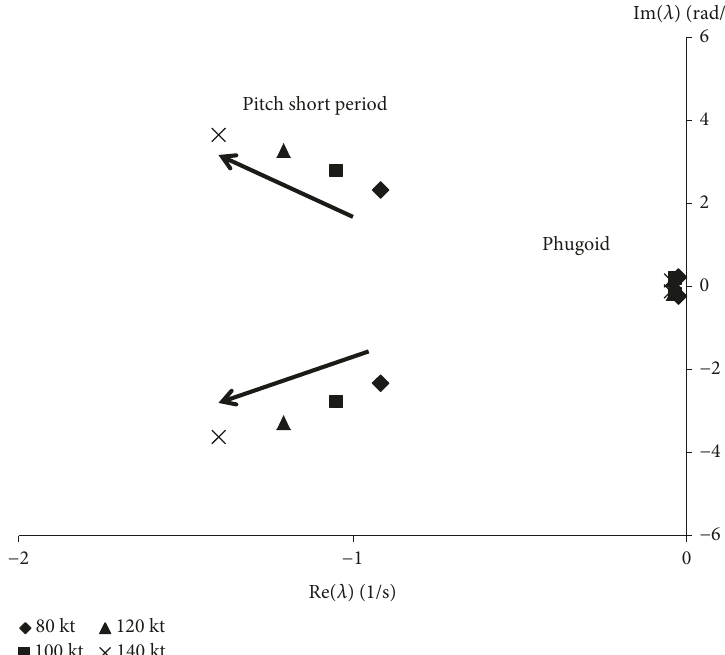
Figure 18: Longitudinal eigenvalue movement in nacelle